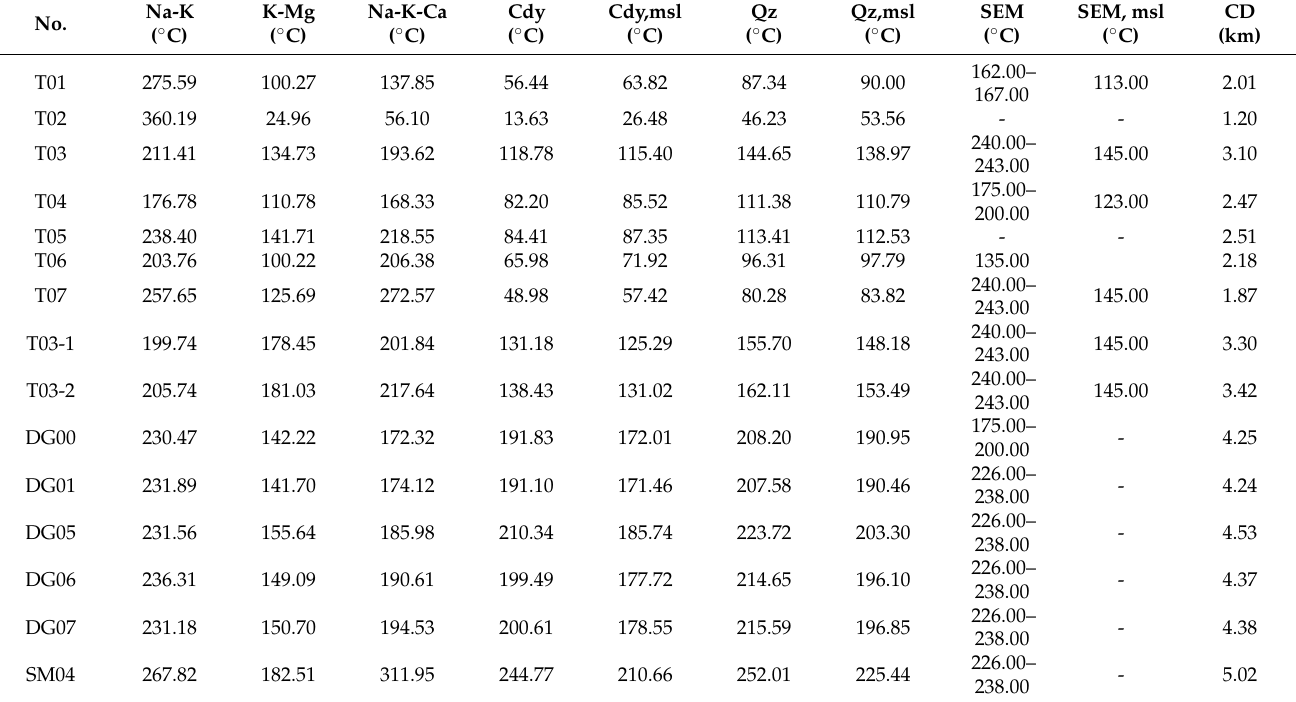
Table 4. Reservoir temperature and circulation depth of the samples along the TNR.